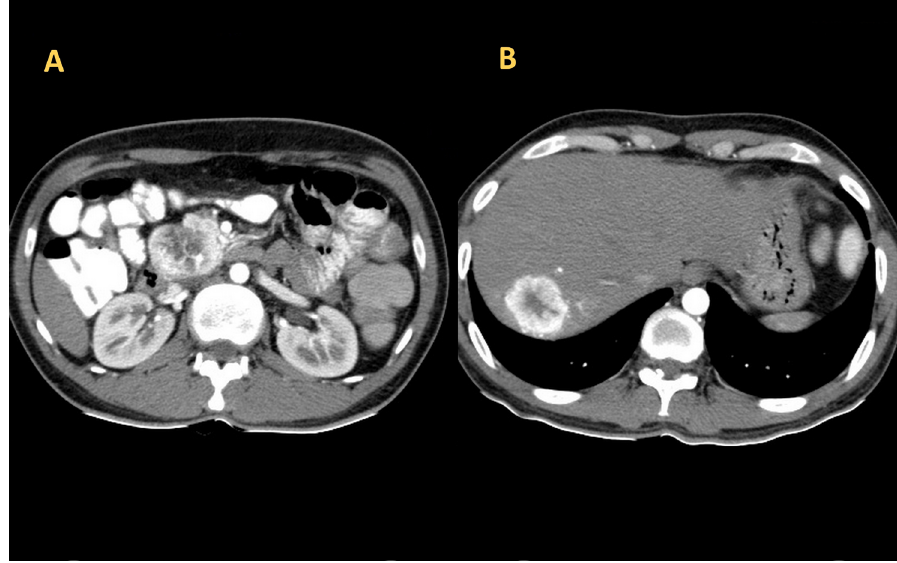
Figure 1. Axial section image of CT scan showing heterogeneously enhancing mass lesion in the head of pancreas (A) and right lobe of liver (B)